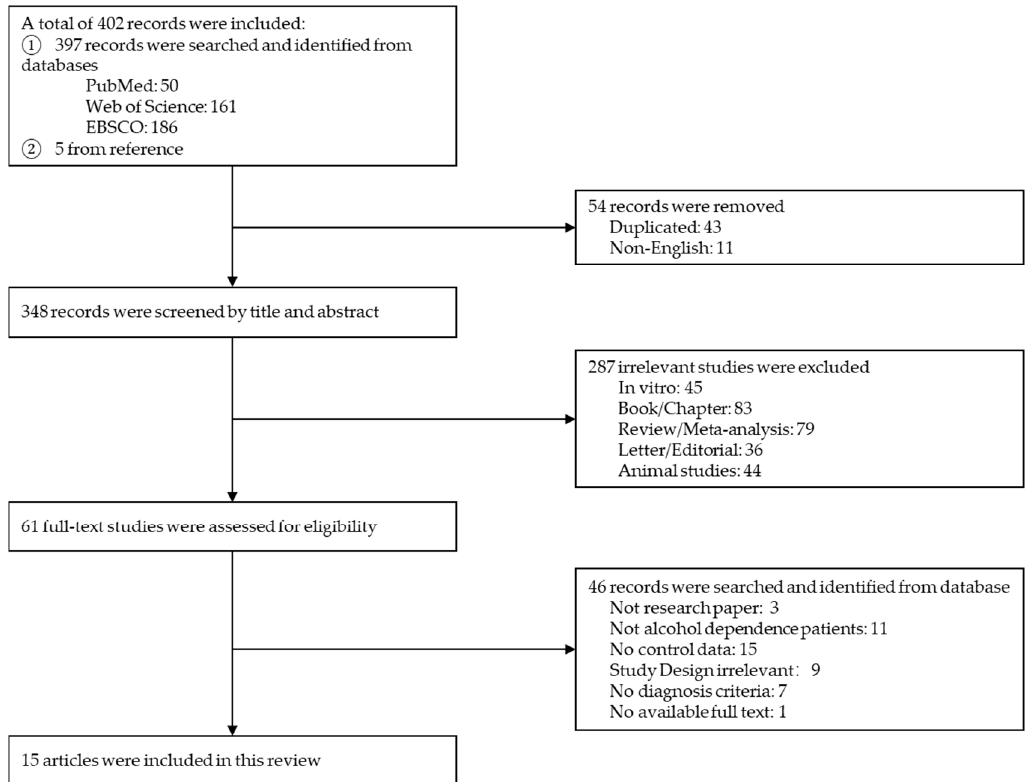
Figure 1. Process of searching and